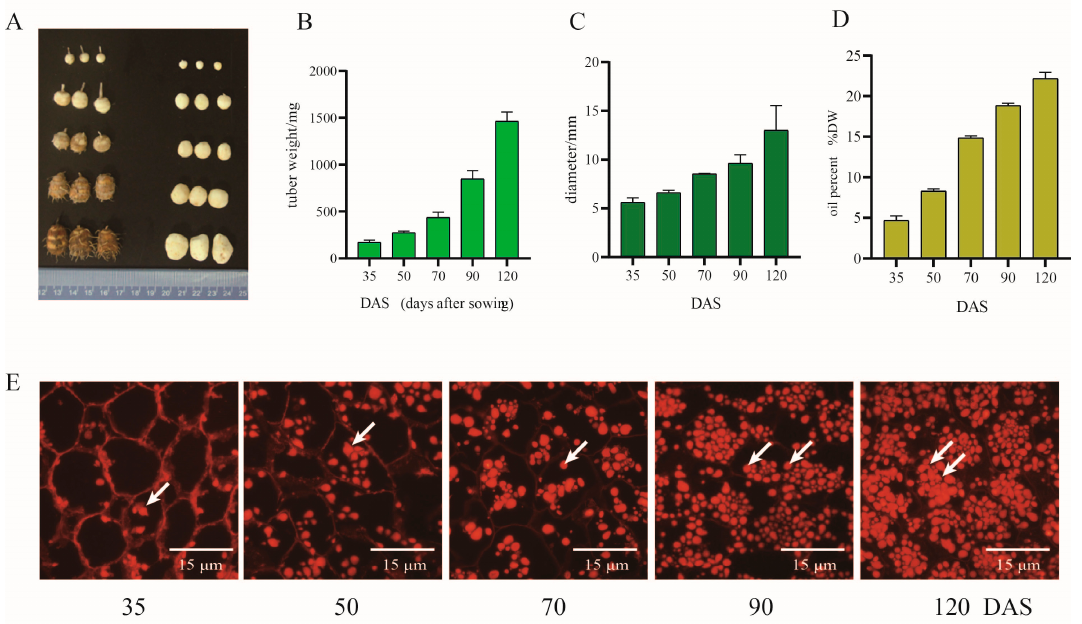
Figure 1. Changes in lipid content and lipid droplets accumulation during tuber development in C. esculentus . ( A ) Changes in appearance and growth status of C. esculentus tubers. ( B ) Average weight changers per tuber under different development stages. ( C ) Average diameter changes per tuber. ( D ) Draw oil content in dry tubers. ( E ) Lipid droplets accumulation inside the C. esculentus tubers. Data indicate means ± SD ( n = 3).